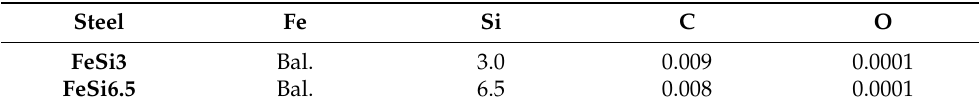
Table 1. Chemical composition (wt.%) of the as-received powders of FeSi3 and FeSi6.5 steels used in the L-PBF system.